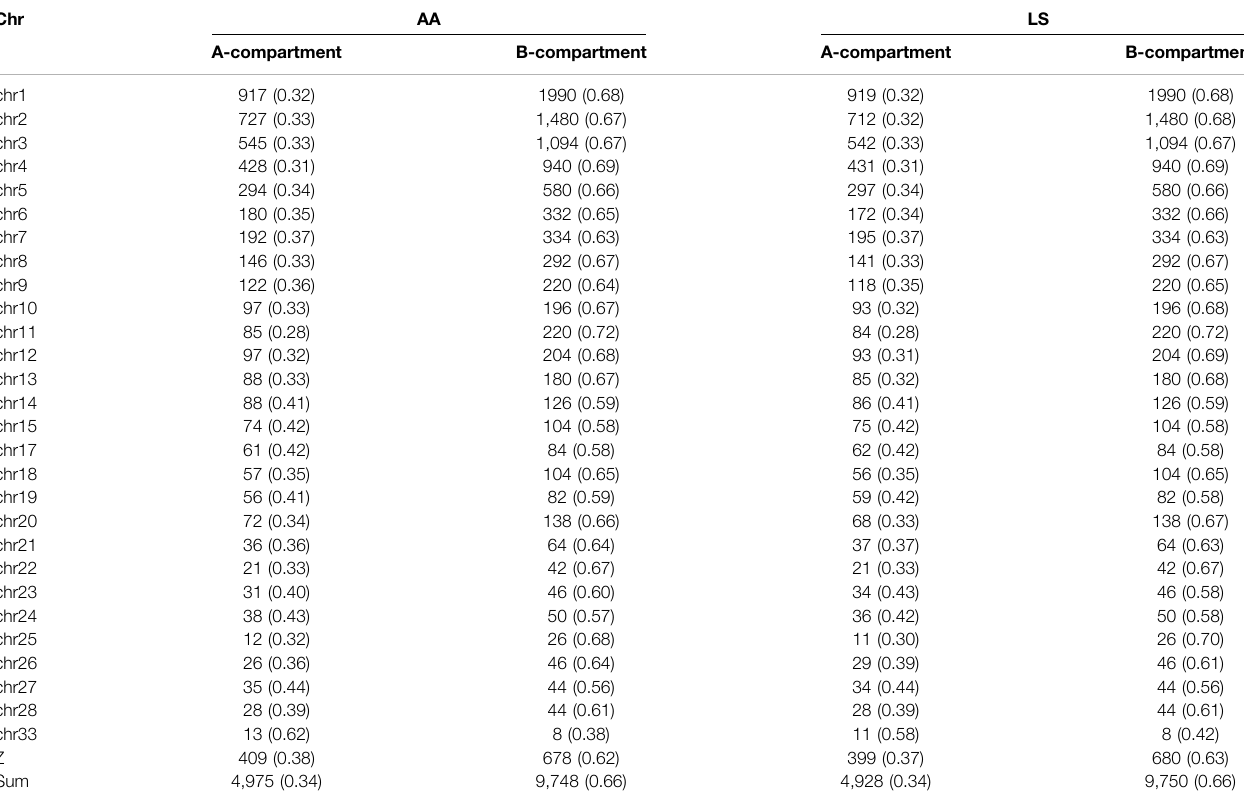
TABLE 3 | The numbers of A/B compartment in genomes of AA and LS chicken breast muscles. Chr